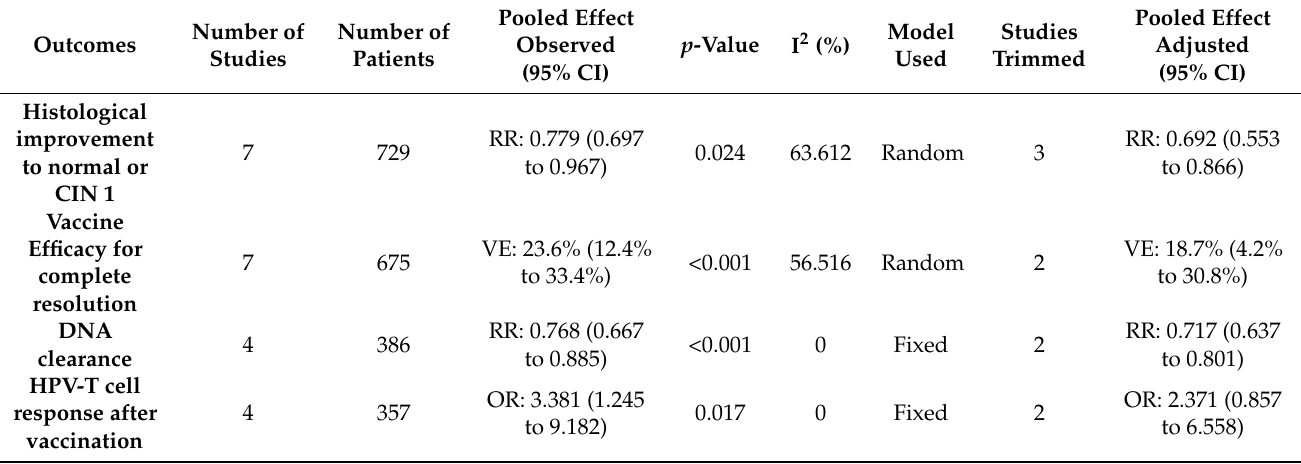
Table 2. Adjusted values of the pooled effect sizes for the absence of publication bias (Duval and Tweedie’s Trim and Fill).